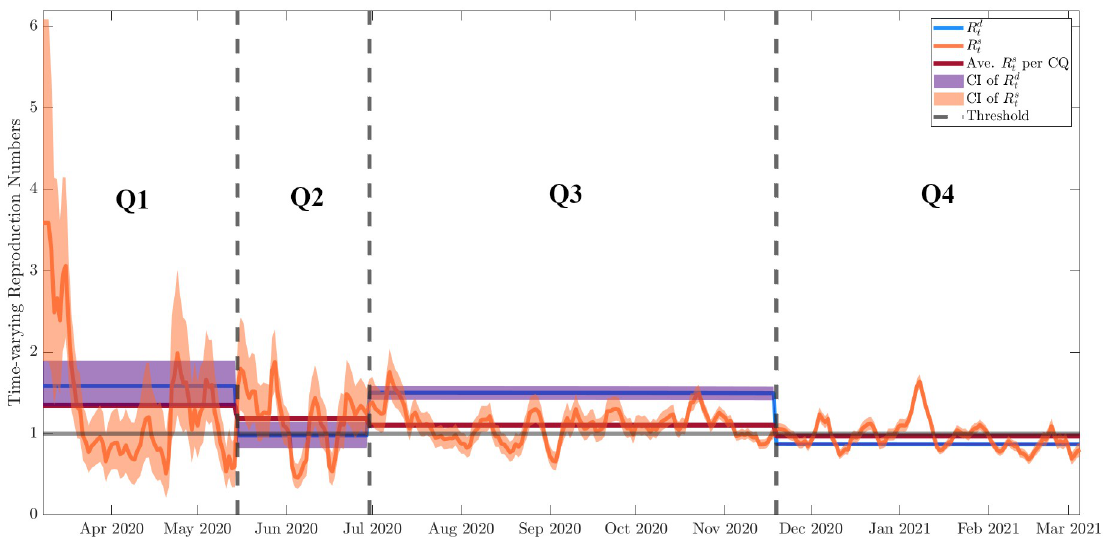
Fig 6. The deterministic reproduction number R d the time periods considered.